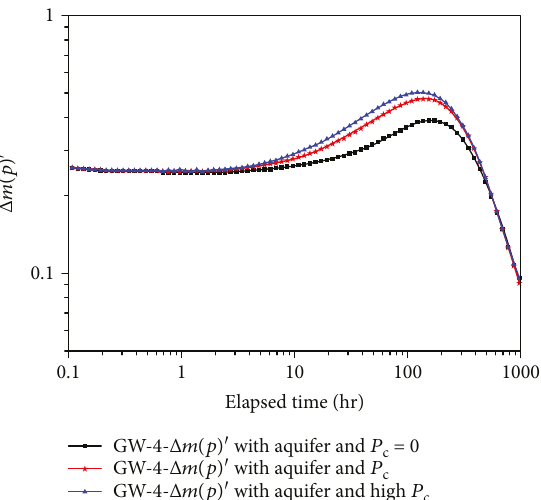
Figure 18: The log-log plot of the pressure response in gas-water reservoir with P and closed boundary. The pressure derivative c with capillary pressure goes up more than that without capillary pressure.